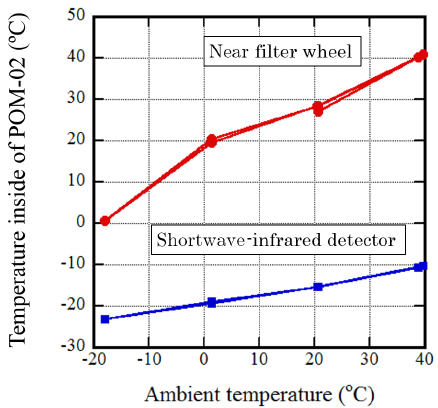
Figure 1. Relation between the inside temperatures of the instru- ment and the ambient environmental temperature for POM-02 (cal- ibration